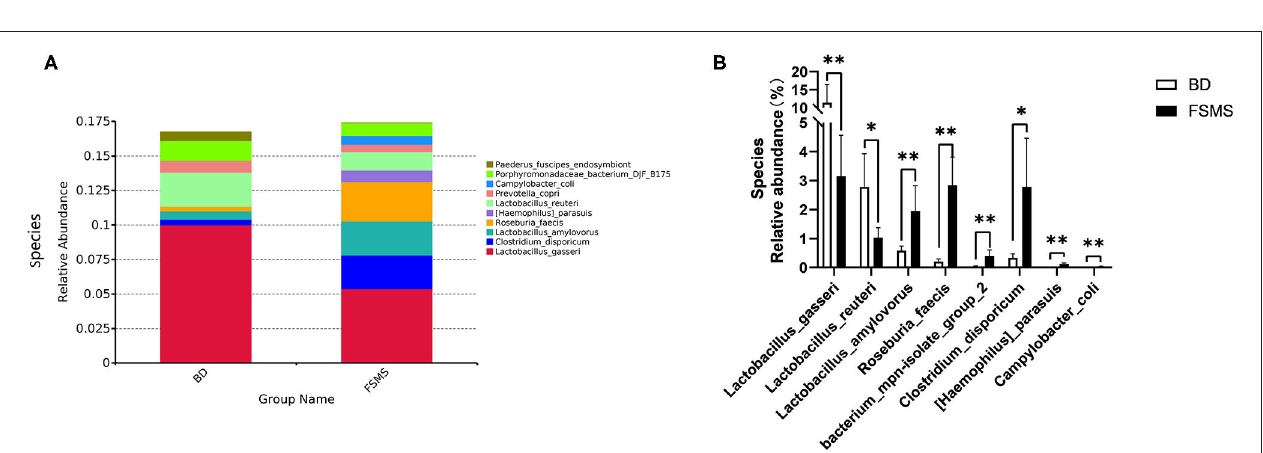
FIGURE 6 | Relative abundance of bacterial species in the cecal digesta of pigs (A) . Significant changed species in the cecal digesta (B) . Values were expressed as means ± SEM ( n = 6). Statistical differences were calculated by Duncan: * p < 0.05, ** p < 0.01.